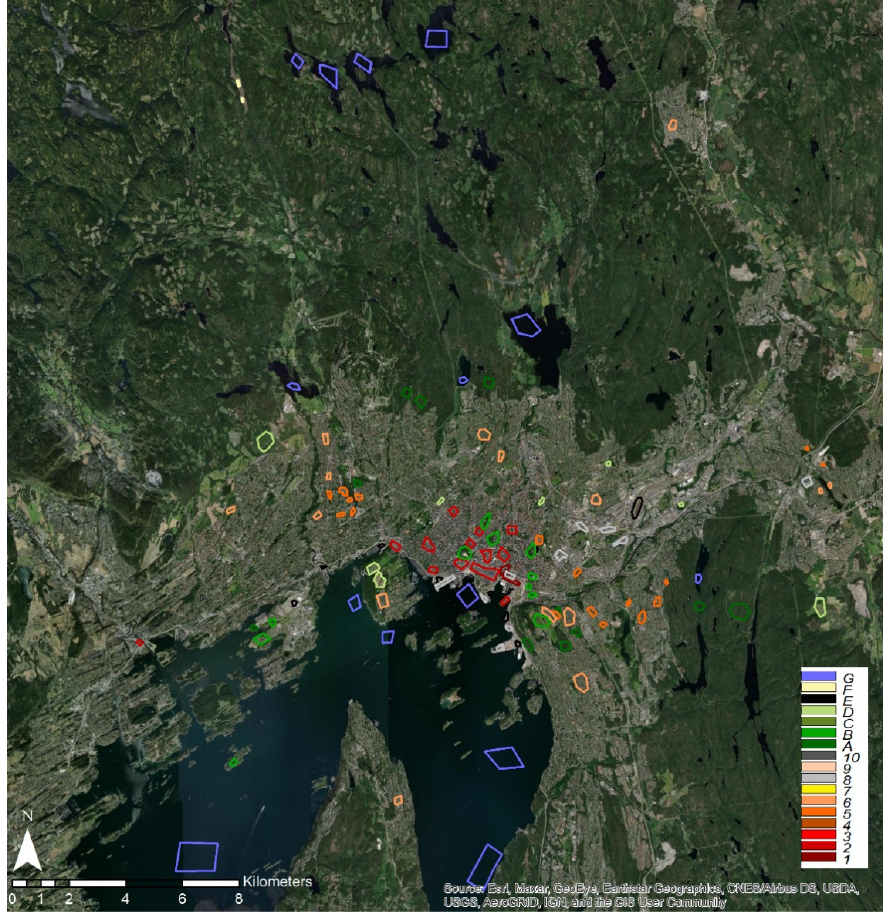
Figure 4. WUDAPT training areas (TAs), Oslo (urban core). The TAs are colored according to LCZ type, using the official WUDAPT palette (legend).